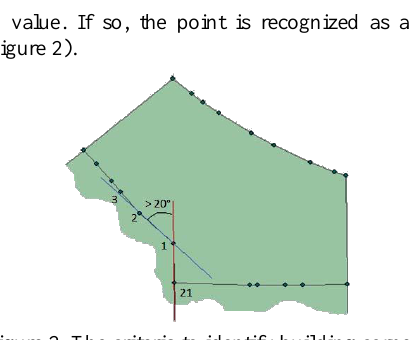
Figure 2. The criteria to identify building